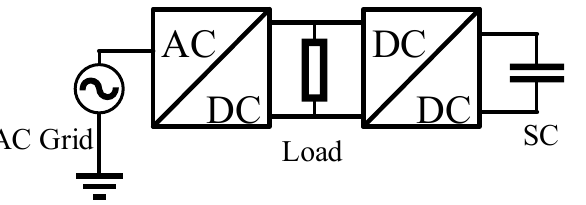
Figure 17. Schematic diagram of a modified supercapacitor and load two-stage converter system.